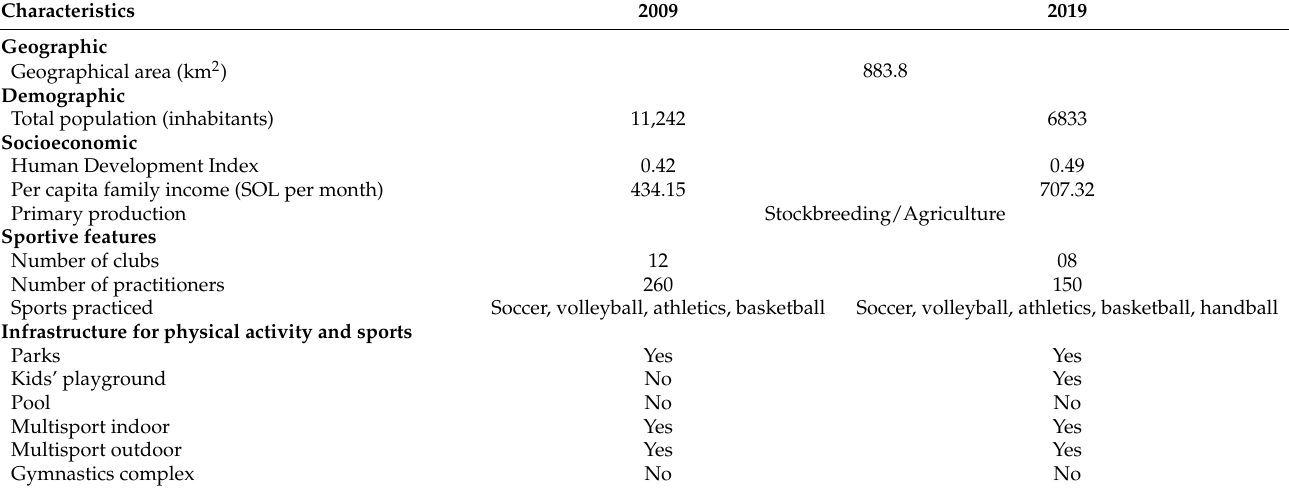
Table 2. Geographic, demographic, socioeconomic, sportive, and physical education classes charac- teristics in Jun í n city in 2009 and